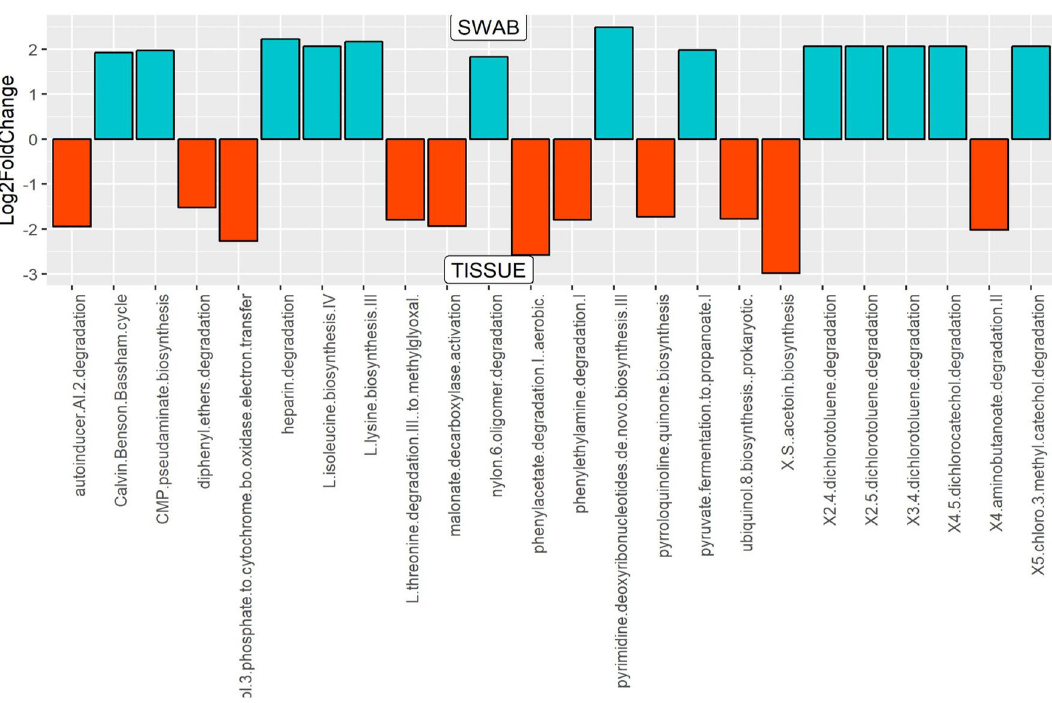
Figure 6. Differentially abundant metabolic pathways identified in cancer tissue and tumor surface by DESeq2 Analysis. Levels of twenty-four metabolic pathways were differentially abundant between the tumor surface and the tumor